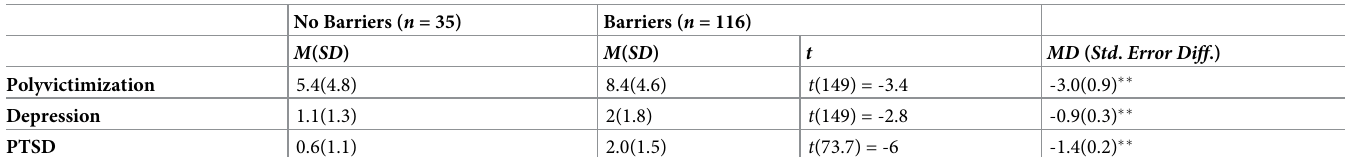
Table 4. Independent T-tests of key variables by exposure to healthcare barriers among the quantitative sample (N = 151). No Barriers ( n =